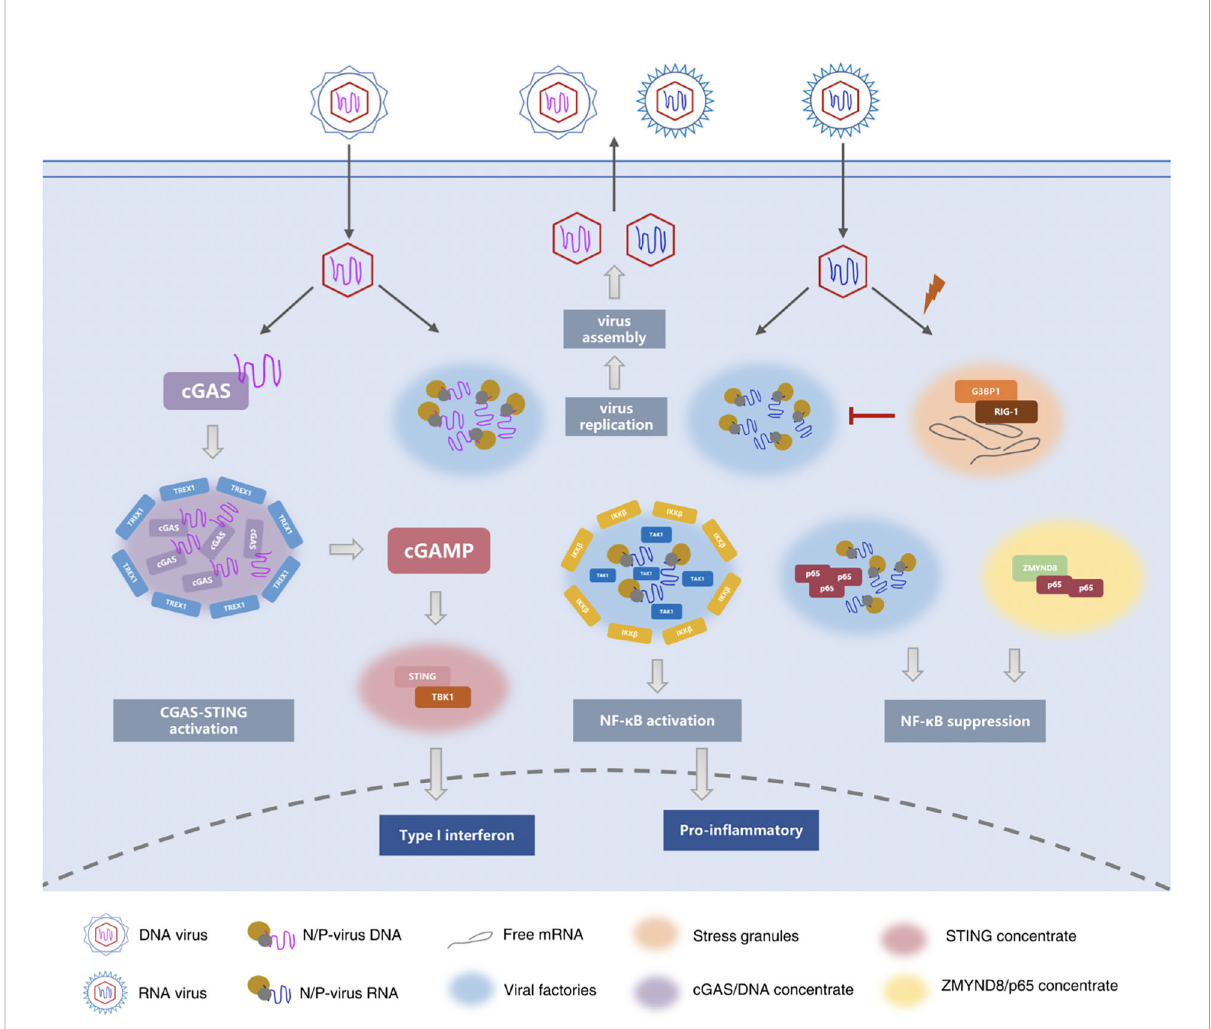
FIGURE 1 Phase separation in innate immune and in fl ammatory responses. During infection, the replication and assembly of many viruses occurs in viral factories or viral inclusion bodies. These structures condense viral proteins, nucleic acids, and cytokines, carry the essential steps of viral replication, and protect the viral genome from cellular defenses. (17 – 19, 58, 59, 63) Similar to virus factories, stress granules (SG) are also be observed during virus infection. The difference is that the virus factory is a liquid-like concentrate that the virus uses to protect itself and stimulates the host to synthesize it, while the stress granules are the defense mechanism formed by the host in the face of viral infection. (74, 75) The cGAS-STING signaling pathway is an important DNA sensing mechanism in the innate immune system. cGAS contains an intrinsically disordered N-terminal domain and a C-terminal catalytic domain, that catalyzes and synthesizes cGAMP. cGAMP then acts as the second messenger to bind and activate STING on the surface of the endoplasmic reticulum. Upon activation, STING recruits TBK1 to promote